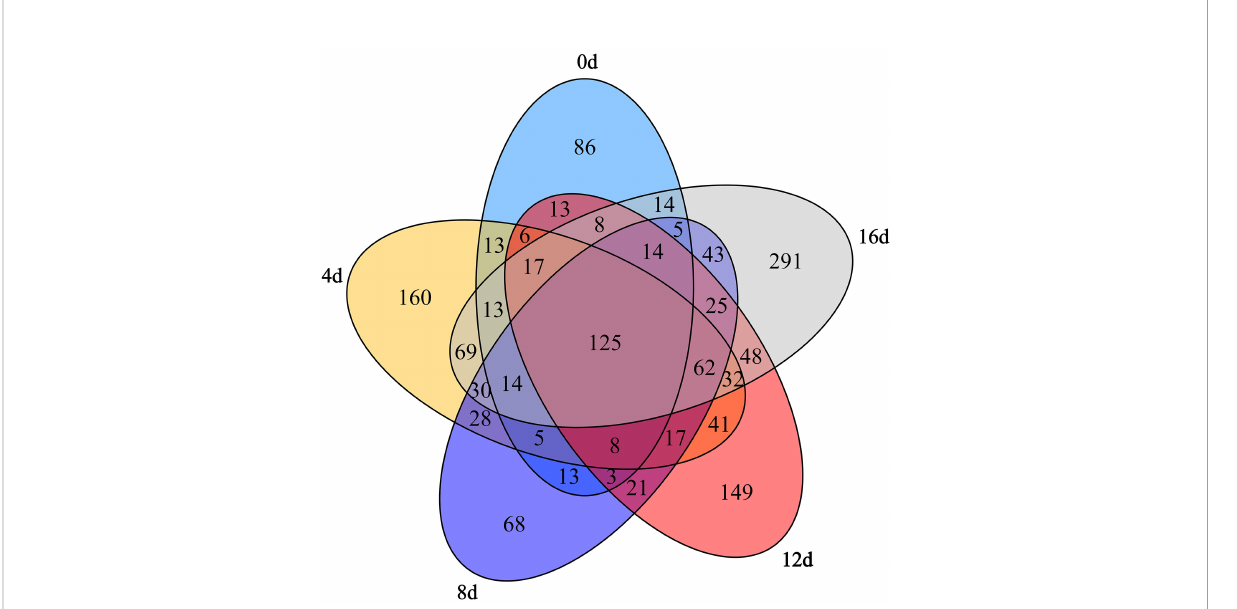
FIGURE 4 Venn diagrams depicting the number of unique and shared OTUs within the gut microbiota of this hybrid species during different swimming exercise